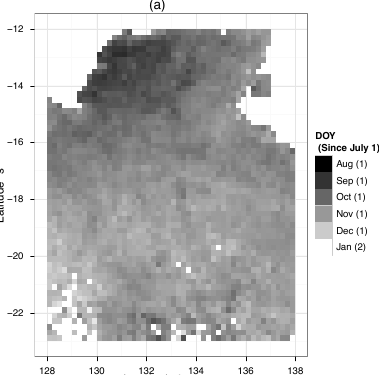
Figure 2: Spatial patterns of 11 years (2000-2011) mean SOS (the date of growing season onset) in the NATT.The numbers in the bracket indicate the calendar years, which 1 means first half of phenological year, i.e. from July 1 to December 31, 2 means second half of phenological year, i.e. from next January 1. Original 0.05 degree resolution result had been aggregated to 0.2 degree resolution for plotting